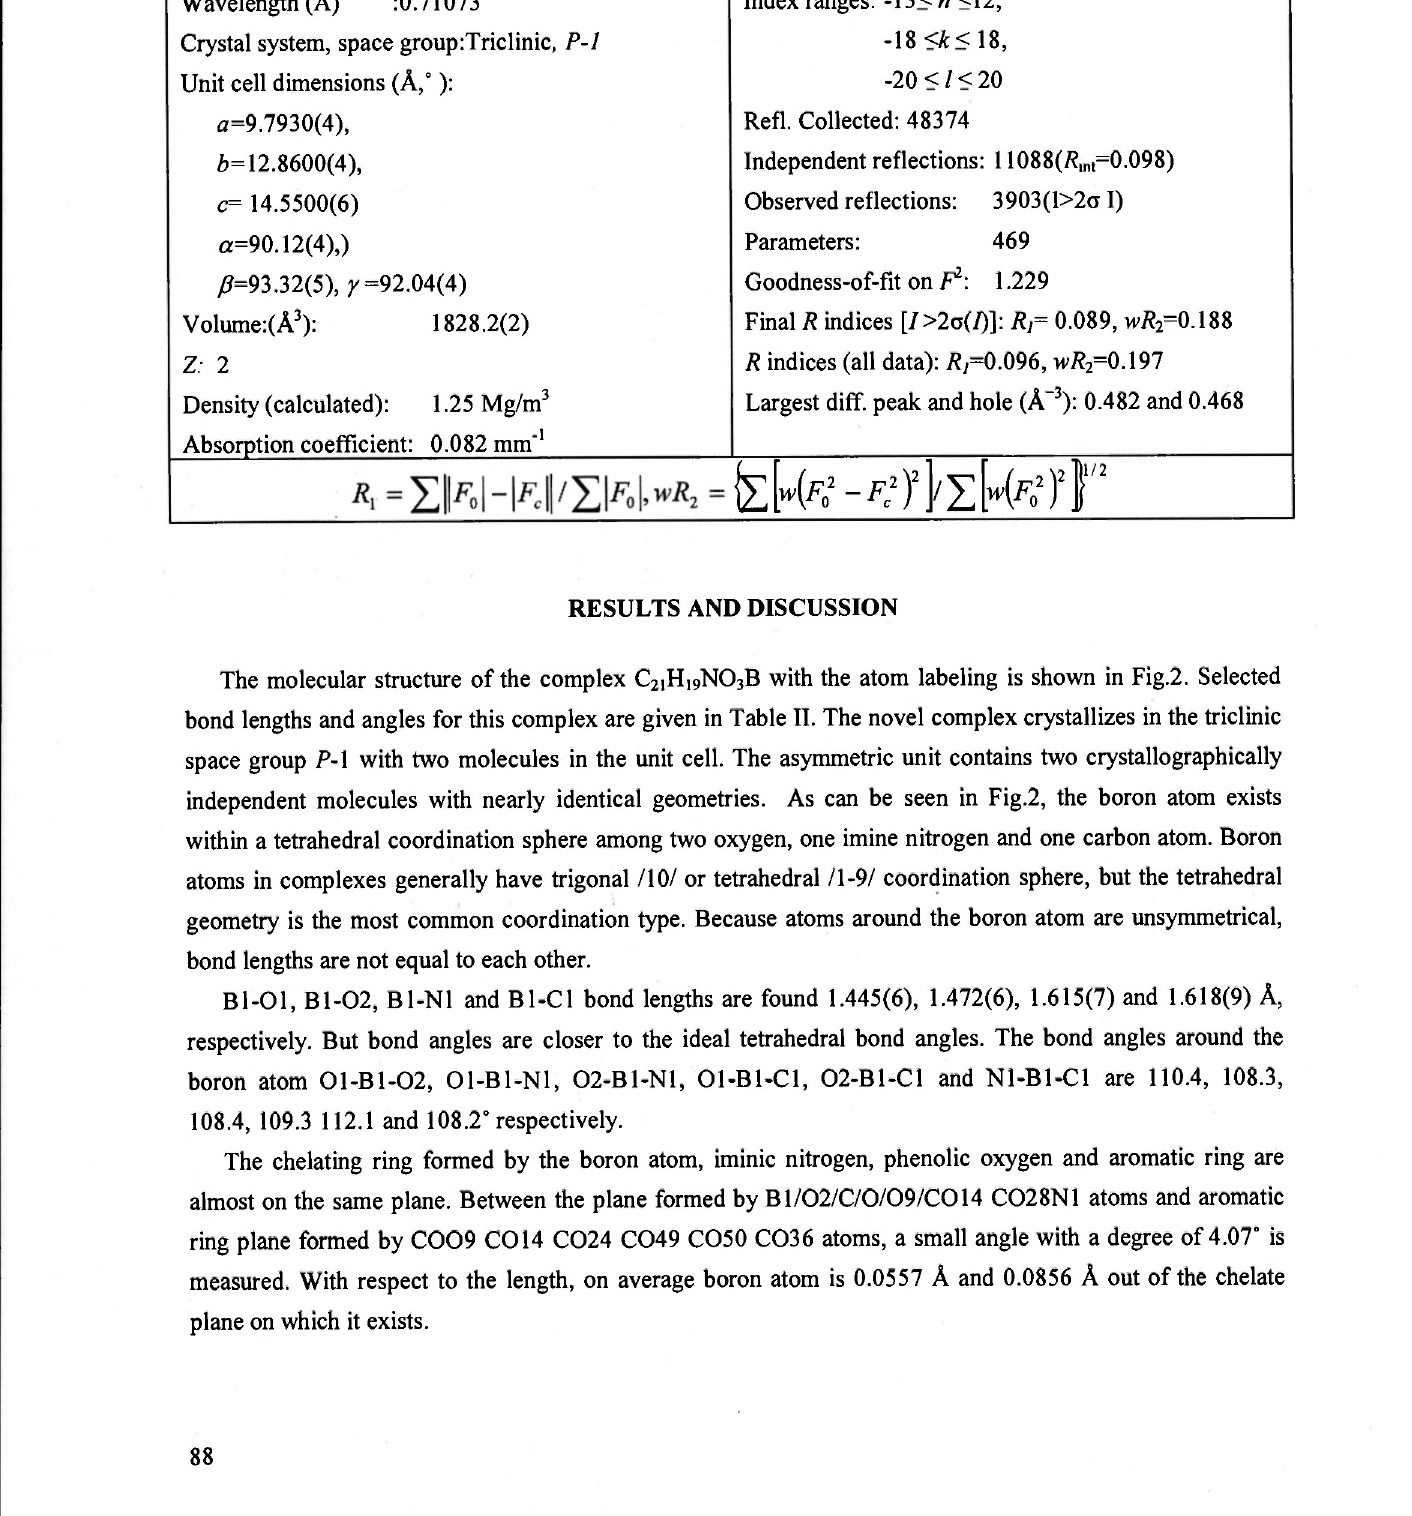
Table I: Crystal data and structure refinement for the